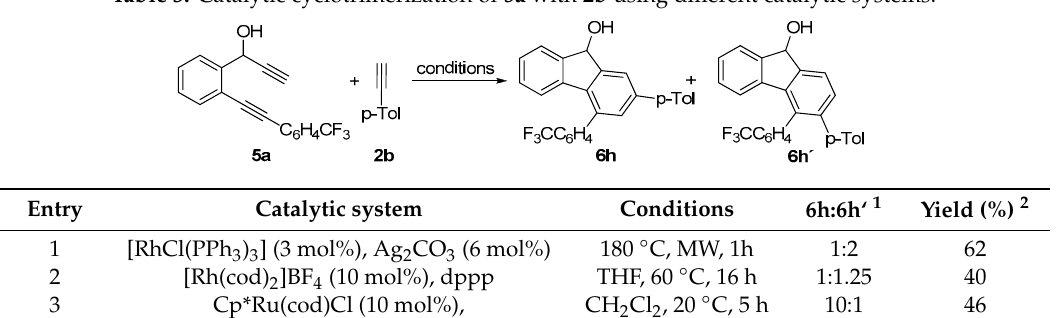
Table 3. Catalytic cyclotrimerization of 5a with 2b using di ff erent catalytic systems.